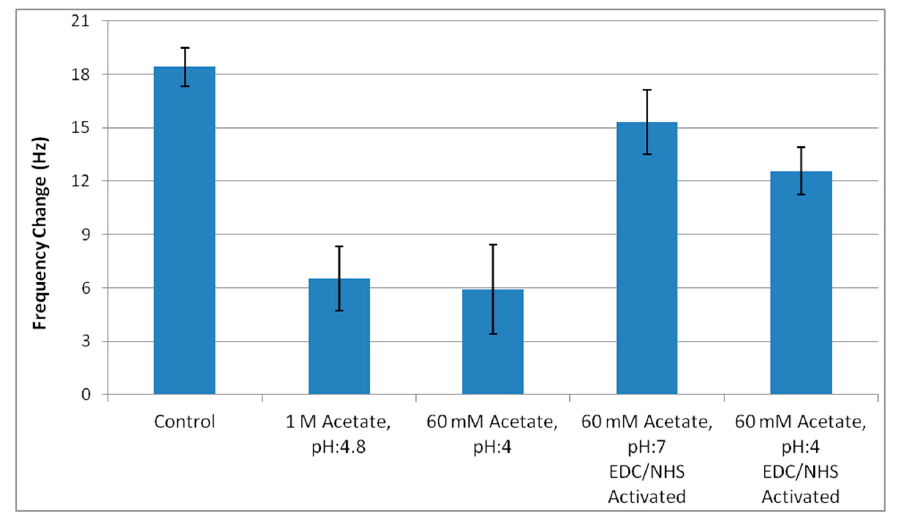
Figure 2. Blocking optimization on amine activated surface. Non-specific protein binding to sensor surface after blocking with 1 M acetate buffer, pH:4.8, 60 mM acetate buffer, pH:4 or EDC/NHS activated 60 mM acetate buffer. Error bars represent standard errors.